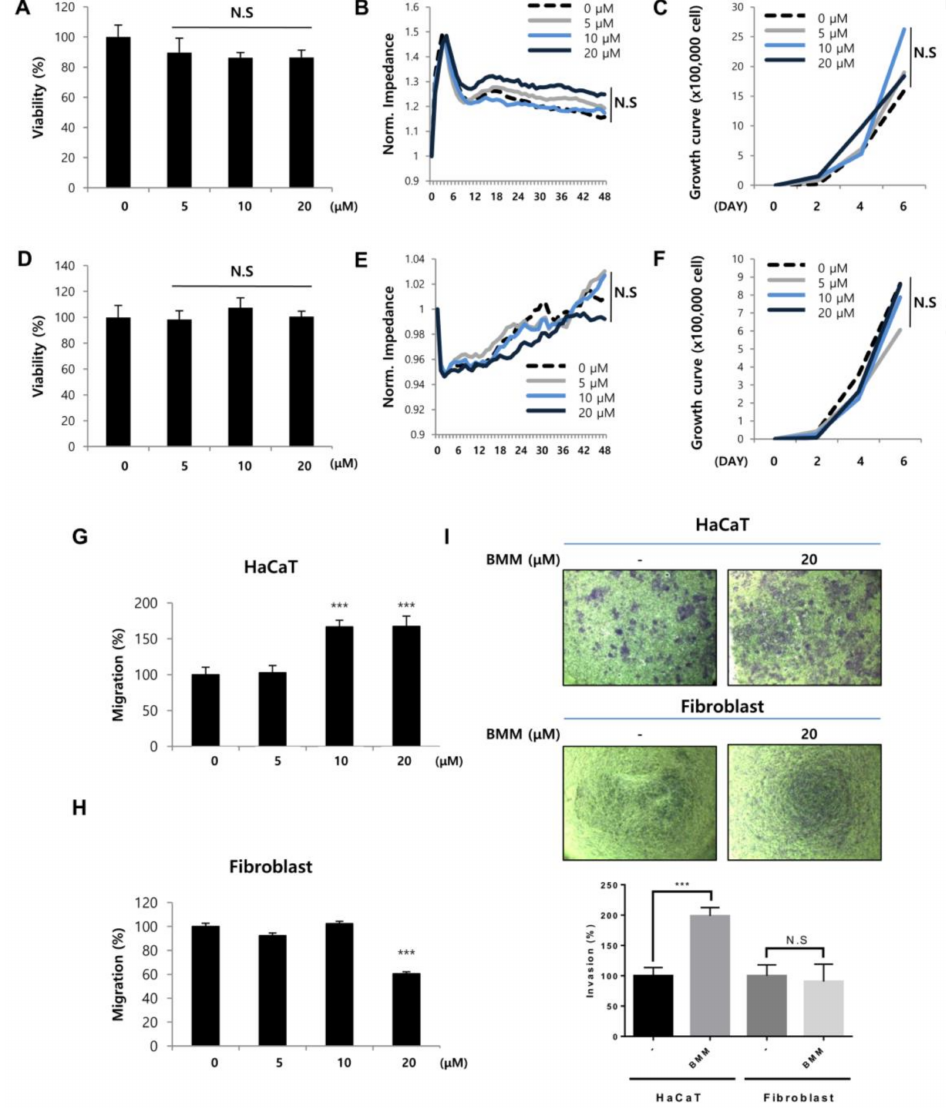
Figure 2. BMM increases basal layer human keratinocytes (HaCaTs) migration but not proliferation and has no effect on proliferation and migration of dermal fibroblasts (Fbs). ( A ) Viability of HaCaTs and ( D ) Fbs. Cells (2 × 10 4 cell/mL) were seeded and treated with BMM (0–20 µ M). After incubation for 24 and 48 h, viability of cells was measured using the MTT solution (5 mg/mL). N.S, not significant; ( B ) Detection of real time proliferation of HaCaTs and ( E ) Fbs treated with BMM. Cells (2 × 10 4 cell/mL) were seeded into eight-well plates pre-coated with 10 mM L -cysteine (Electrode-stabilizing solution). Cells were treated with 5–20 µ M of BMM and measurement was started at 48 h by using the ECIS machine. Resistance was calculated with a ratio compared to 0 h. N.S, not significant; ( C ) Cell counting assay of HaCaT and ( F ) Fbs treated with BMM (0–20 µ M). Cells were seeded (5 × 10 3 cells/well) of on six-well plates and the following day, cells were treated with various concentrations of BMM. After two, four, and six days, cells were collected using 1 × Trypsin and counted using a hemocytometer after centrifugation. N.S, not significant; ( G ) Scratch wound healing assay with HaCaT and ( H ) Fbs treated as described in ( A ) 48 h post-treatment. Migration distance was measured using the ImageJ program; ( I ) Transwell invasion assay with HaCaTs and Fbs treated with 20 µ M BMM for 48 h; Invasive ability was measured as described in the Materials and Methods and is quantified under the graph. *** p < 0.001 as compared to that of the control, N.S, not